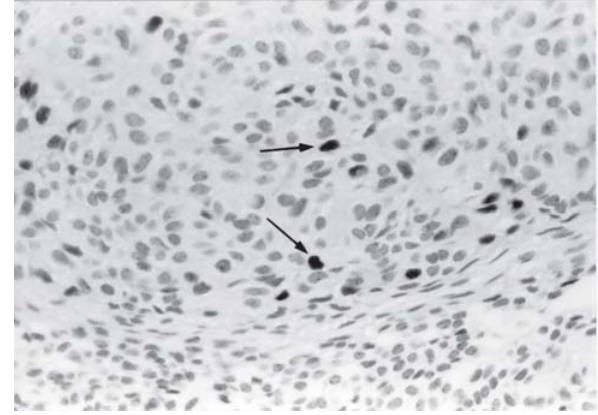
FIGURE 1- Adenomatoid odontogenic tumor: CK 14 citoplasmic positivity only in the fusiform and stellated cells (arrow) adjacent to the solid nodules (A). X400